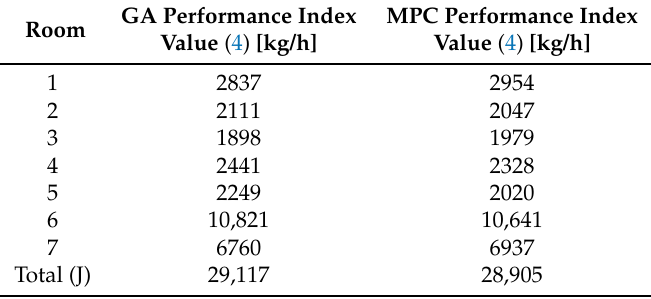
Figure 18. One day simulation, 10 December, for room 7 (ARMAX model). Top : user defined set point ˜ T i (red line), optimized set-point ramp signal ¯ T i (blue line), temperature evolution T i in case of genetic algorithm set-point signal (green line), temperature evolution T i in case of MPC (light blue line). Bottom : resulting inlet water flow in case of ramp set-point signal (blue line) and in case of MPC (green line). Table 10. Performance index value (4) for each room when both the genetic-based optimization and Model Predictive Control (MPC) are applied to the system. In this case, the genetic algorithms (GA) optimization is based on the weather conditions of the day after (10 December), as the